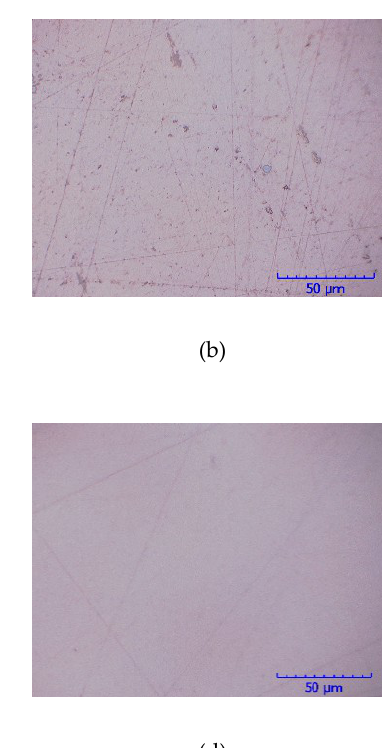
Figure 12. MRR and Ra of Z-cut and X-cut.